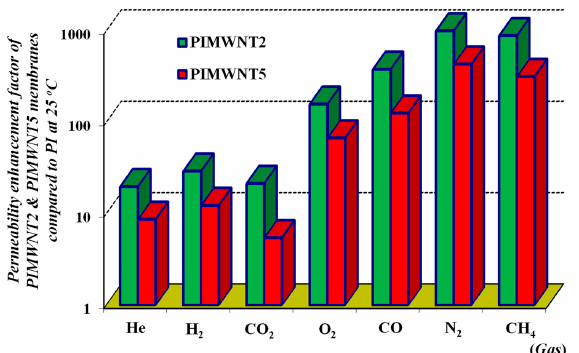
Figure 10. Permeability enhancement factor of PIMWNT2 (green area) and PIMWNT5 (red area) membranes compared to PI at 25 °C.